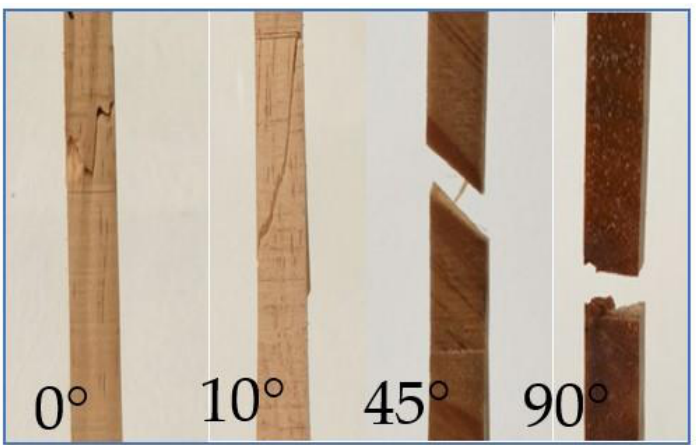
Figure 8. Typical failure modes of the tensile samples for four grain directions; the photo for a grain angle of 90° is from a side view.